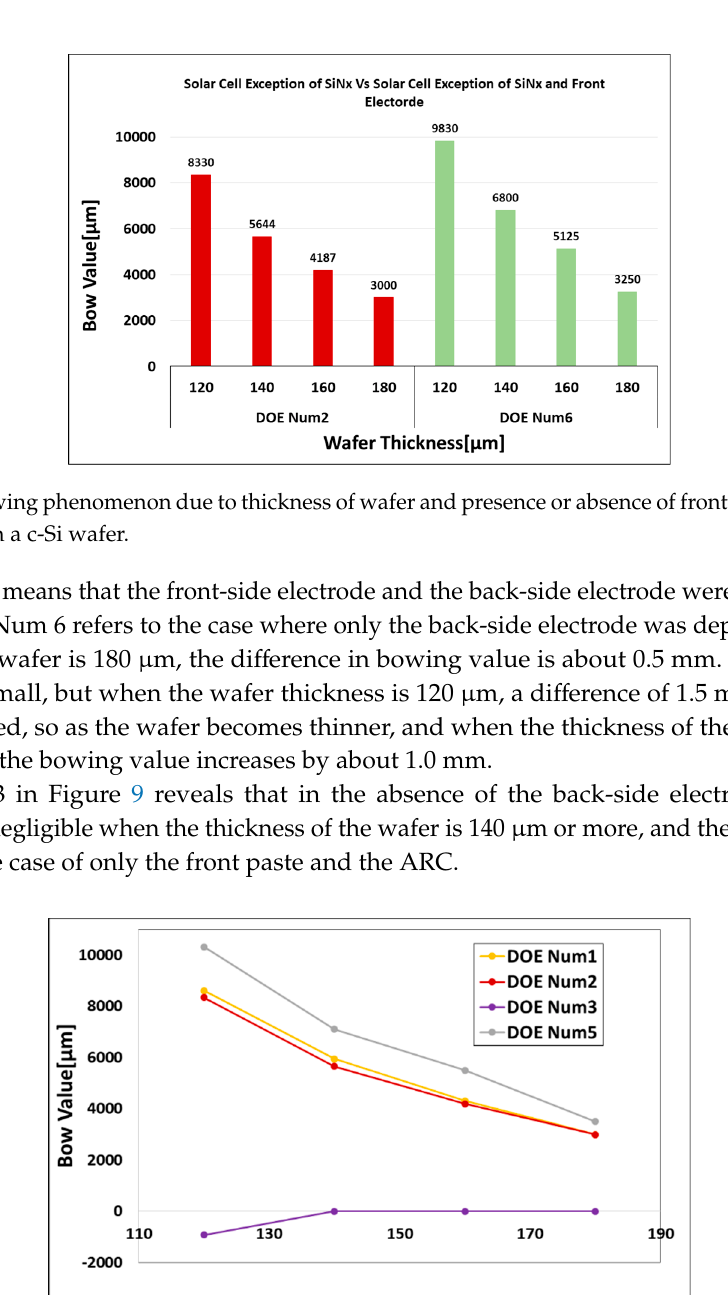
Figure 9. Results of bow experiments 1, 2, 3, and 5.